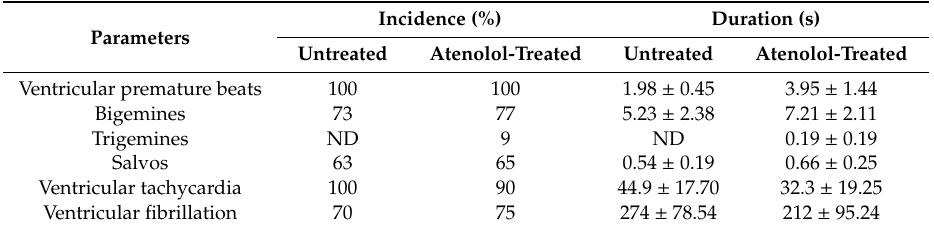
Table 1. Incidence and duration of di ff erent types of arrhythmias due to coronary artery occlusion in rats with or without beta-adrenoceptor blocker, atenolol (20 mg / kg / day) treatment for 14 days.